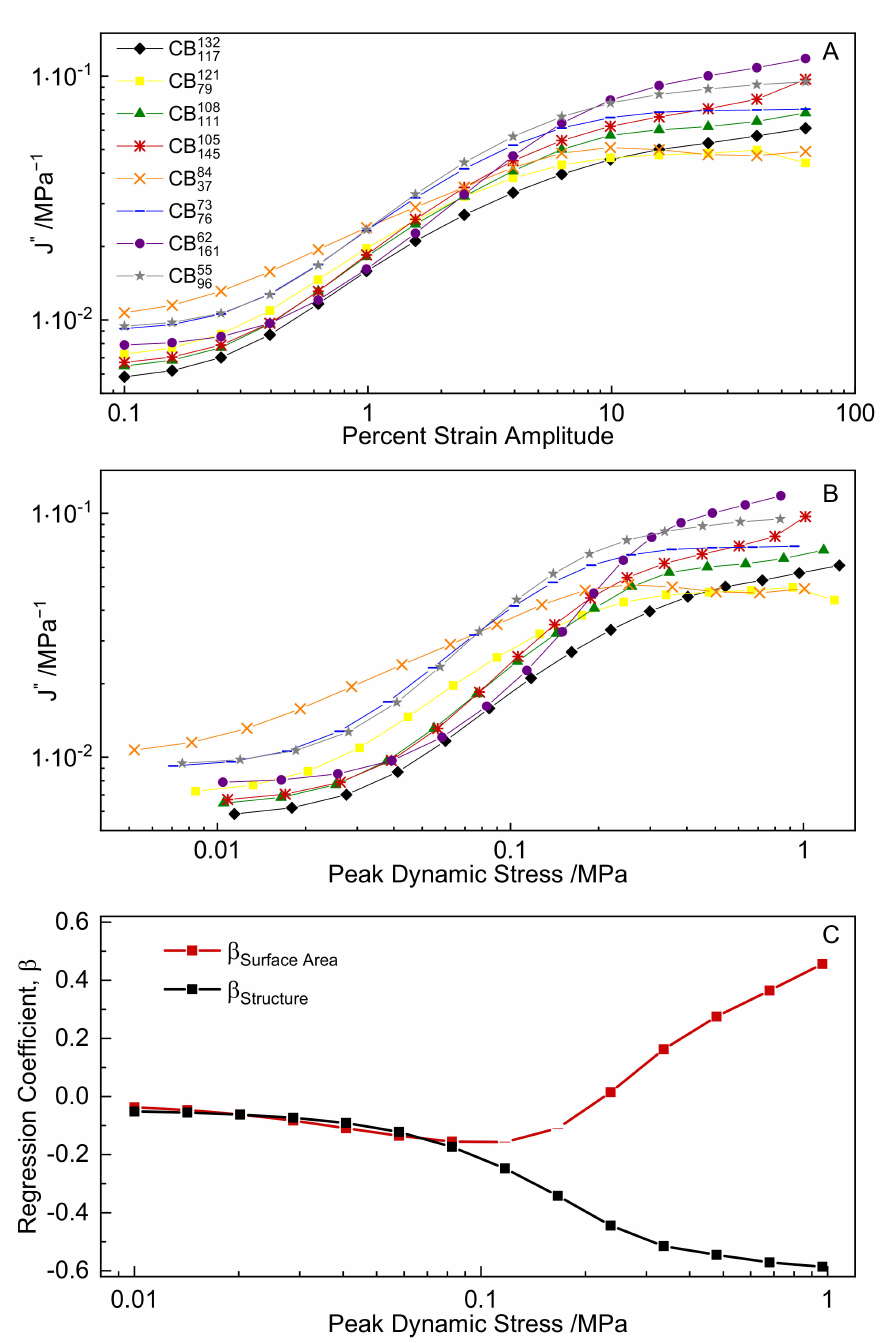
Figure 10. ( A ) J (cid:48)(cid:48) plotted versus strain amplitude; ( B ) J (cid:48)(cid:48) plotted versus peak dynamic stress; ( C ) multiple regression coefficients for structure and surface area plotted versus peak dynamic stress (points with p values > 0.05 are shown as